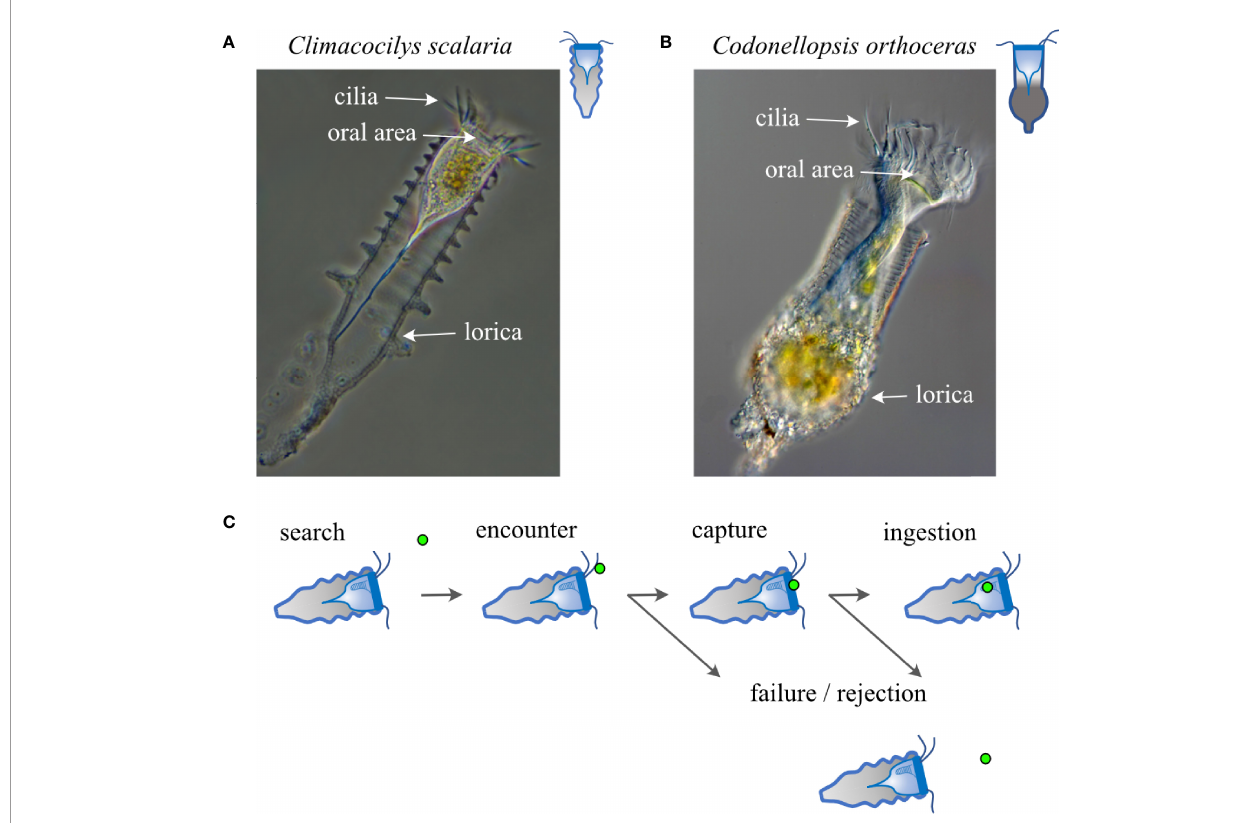
FIGURE 1 | Study species and the major stages of prey capture. (A, B) Images of Climacocilys scalaria (A) and Codonellopsis orthoceras (B) , illustrating the morphology of their lorica and cell body. The lorica diameter of Climacocilys scalaria is 46-63µm, and that of Codonellopsis Orthoceras is 54-62µm. Illustrations to the right of the image are used throughout the fi gures to depict species. Images are from https://planktonnet.awi.de/ and are used under Creative Commons attribution 3 (C) Prey capture is composed of sequential phases that include search, encounter, capture, handling, ingestion, and digestion (Montagnes et al., 2008). “ Search ” is de fi ned as the phase in which the tintinnid is actively moving itself or the water around it to facilitate prey encounters. “ Encounter ” is de fi ned as the initial contact between the tintinnid and its prey. “ Capture ” is de fi ned as the successful transfer of the prey item into the oral area. “ Handling ” is the process of moving the prey into the oral groove where “ ingestion ” and later digestion occur. Unsuccessful outcomes can occur following encounter (hereafter “ failure ” ) and capture (hereafter “ rejection ” ). Note that selectivity can develop due to the predator adjusting its behavior during any of the above